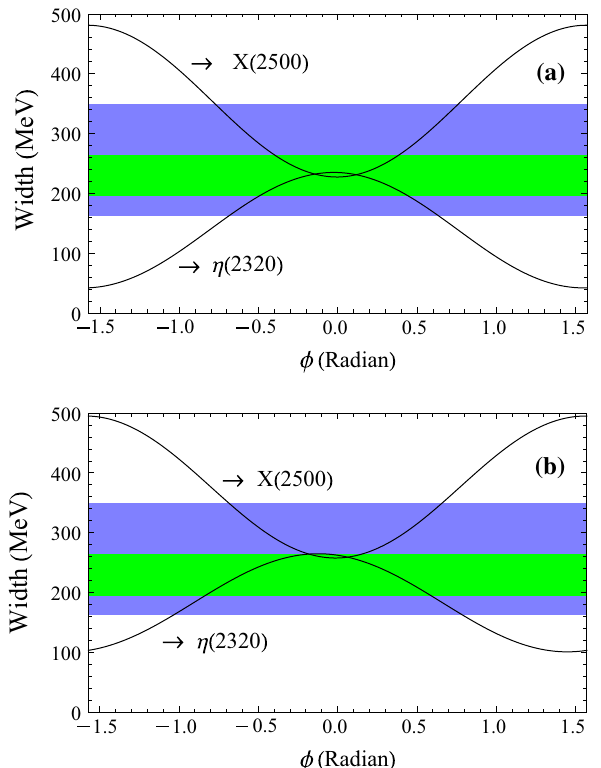
Fig. 3 The dependence of the η( 2320 ) and X ( 2500 ) total widths on the φ in the 3 P 0 model with two types of wave functions: a with the SHO wave functions b with the RQM wave functions. The blue and green bands denote the measured widths for the X ( 2500 ) and η( 2320 ) , respectively